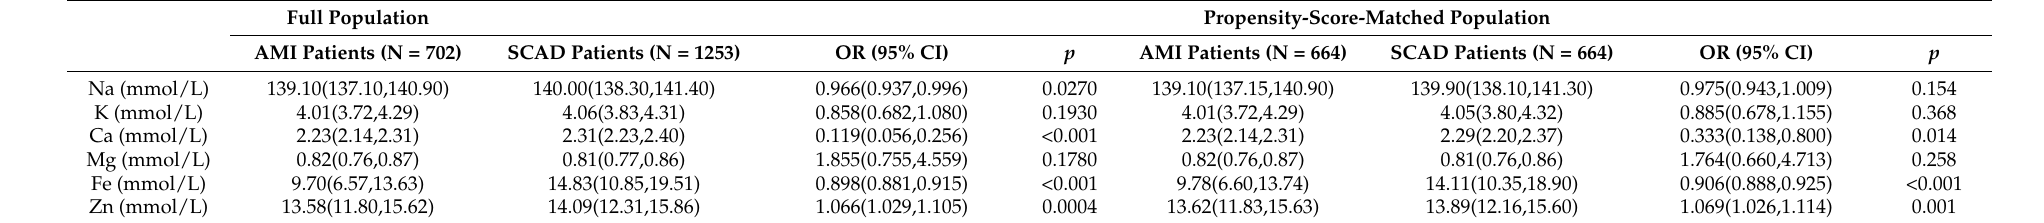
Table 5. Association between the levels of metals and AMI—SCAD risk in the multivariable logistic regression